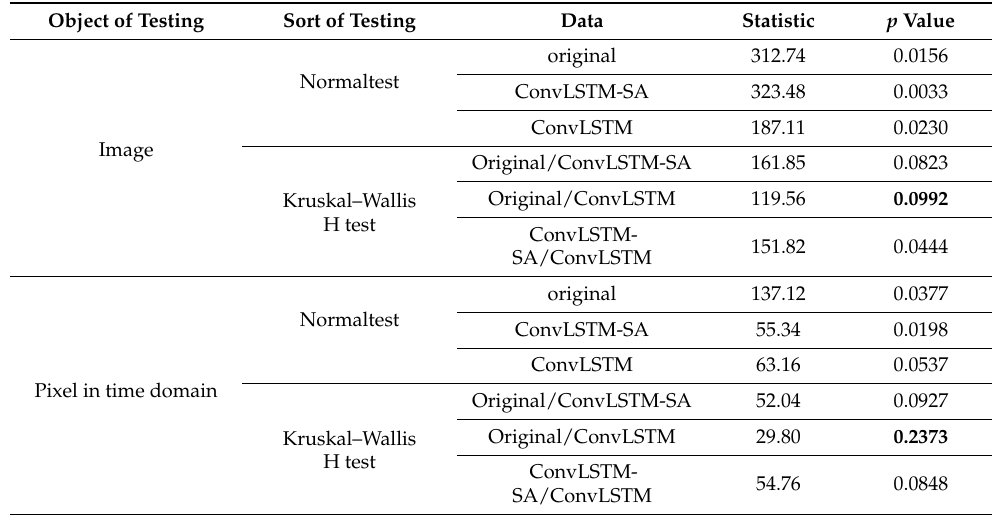
Table 7. Results of statistical testing for predicted images and pixels in the time domain for the test